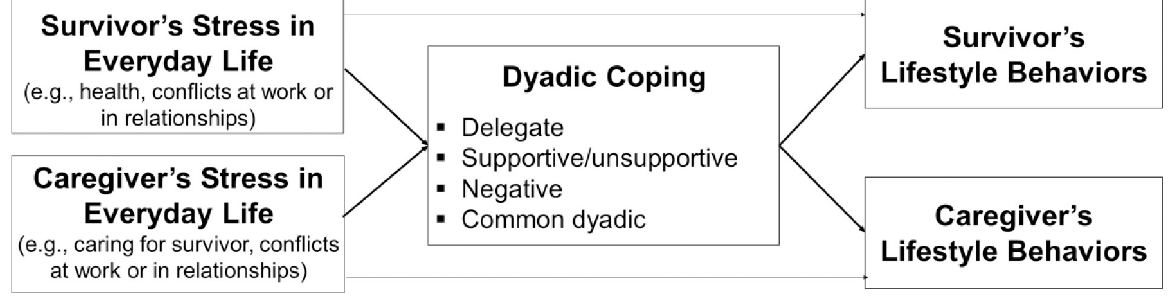
Fig 1. Conceptual